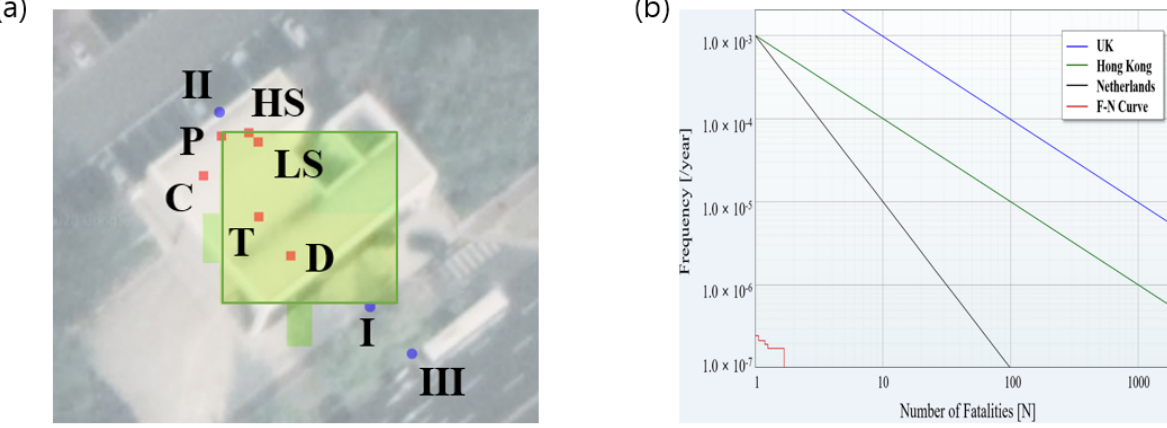
Figure 5. Analysis of societal risk according to applied to passive IPLs. ( a ) Analysis of the contribution of societal risk posed by hydrogen refueling facilities and ( b ) F–N curve analysis according to the application of passive IPLs.